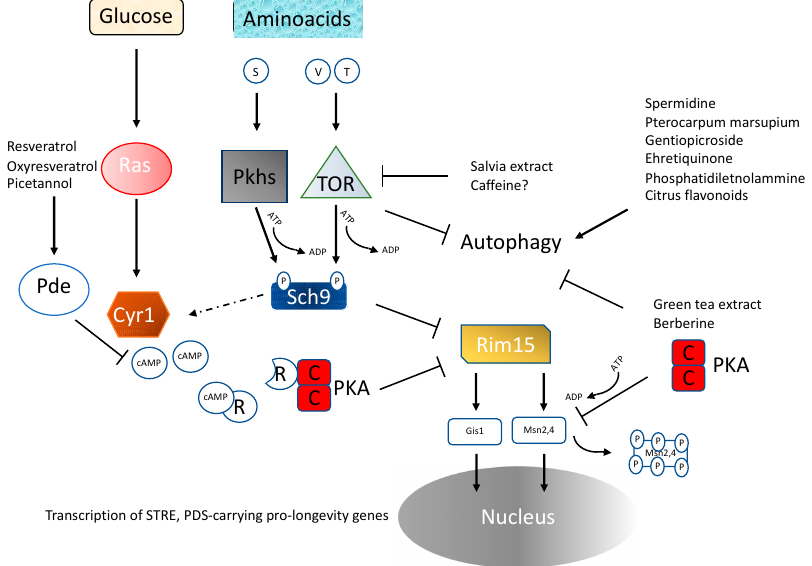
Figure 2. A detailed scheme of yeast longevity/nutrient pathways reporting the natural substances with modulating effects. Adapted from [34].